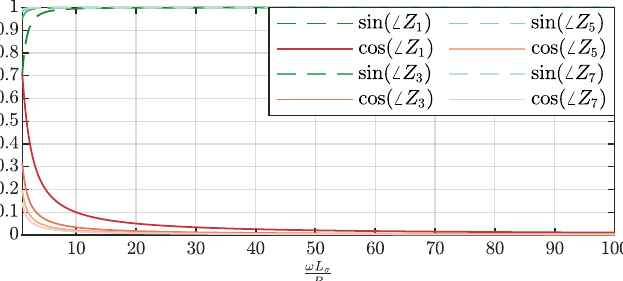
Figure 3. Dependencies of sin ( ∠ Z H ) and cos ( ∠ Z H ) on the ratio of ω L σ to R for four